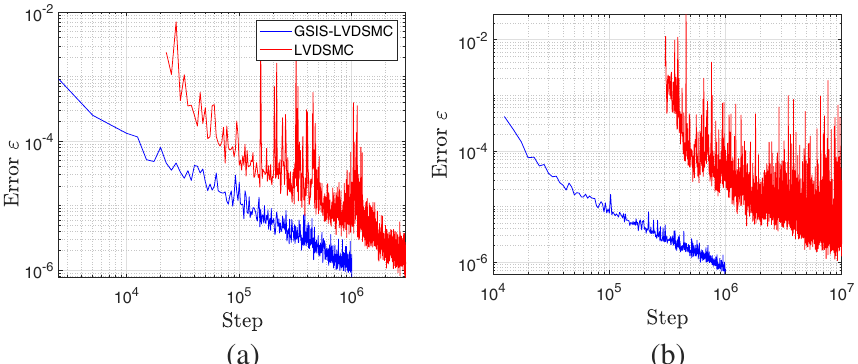
Fig. 10 Decay of the relative error ε in steady state with the iteration step for planar Fourier flow obtained by GSIS-LVDSMC (blue lines) and LVDSMC (red lines). a Kn